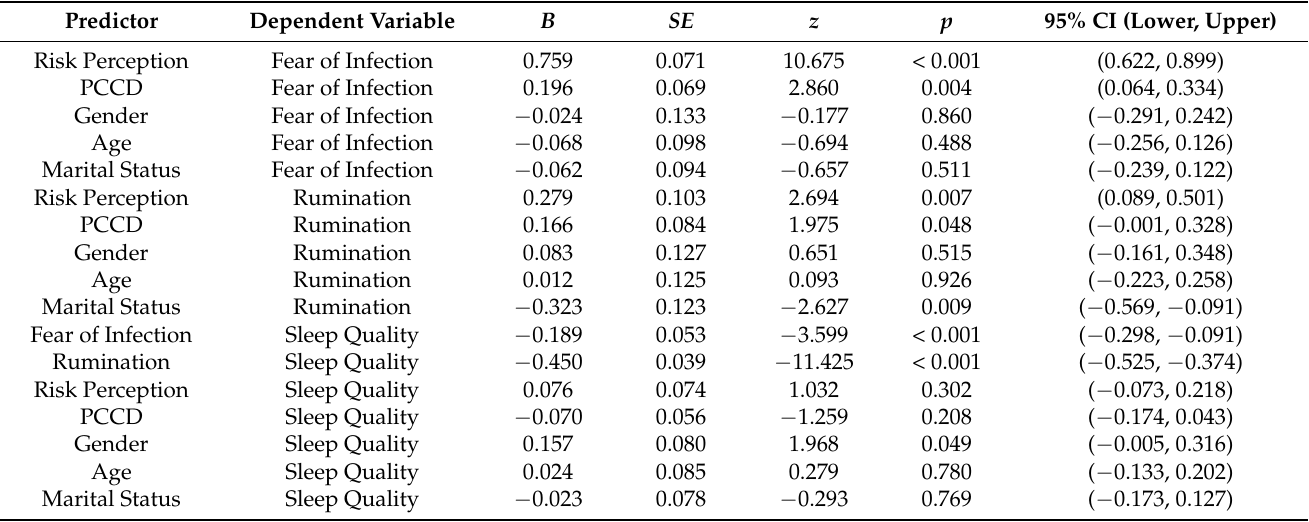
Table 4. Direct effects.